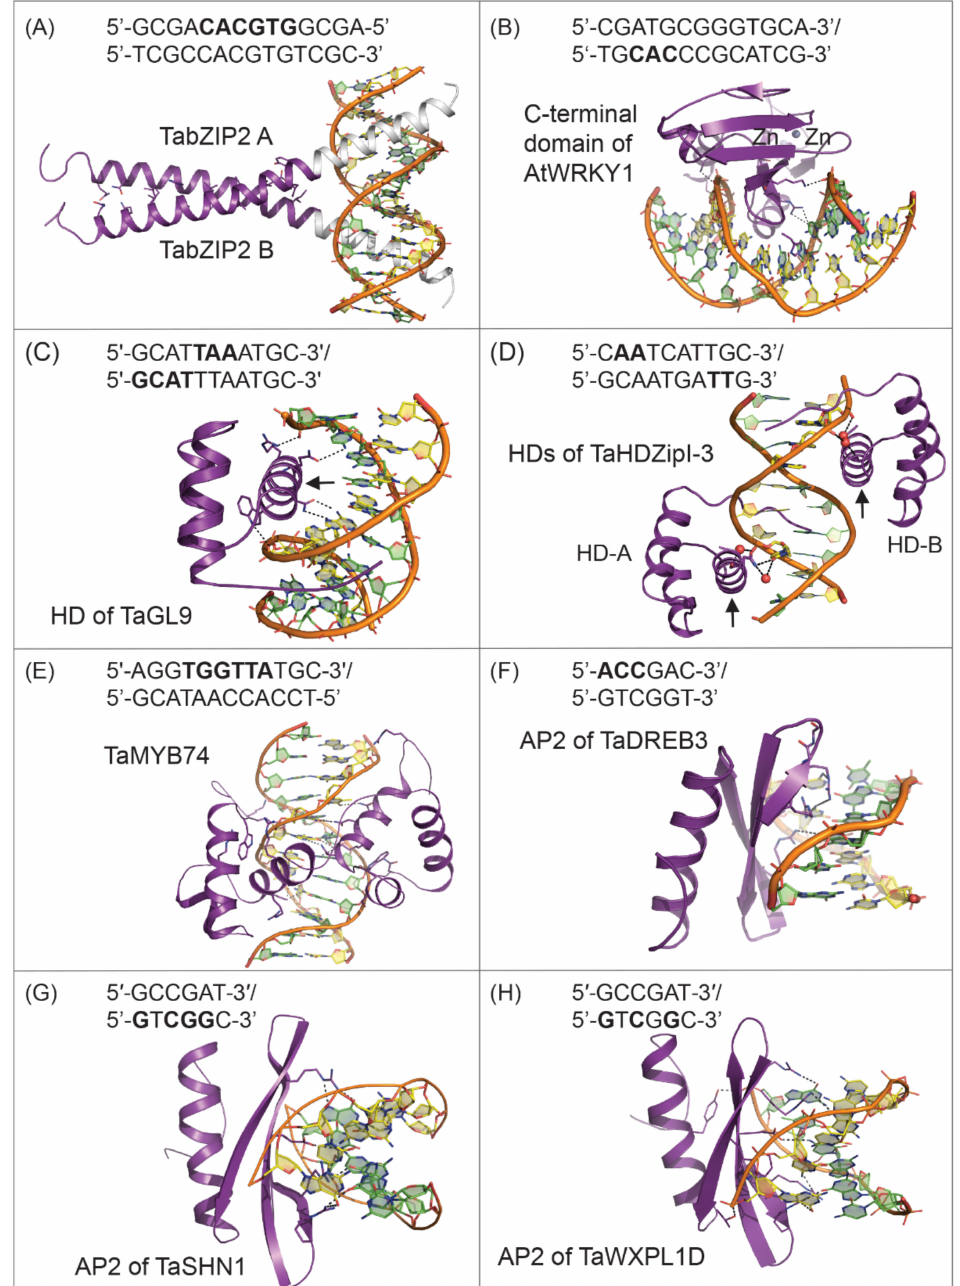
Figure 4. Structural characteristics of selected classes of wheat ( Triticum aestivum L.) and Arabidopsis thaliana (L. Heynh) TFs involved in drought and other abiotic stresses. Coding and complementary DNA strands are shown in cpk yellow and cpk green sticks, respectively. Residues that interact with DNA are shown in cpk purple sticks and separations are illustrated in black dashed lines. DNA nucleotides ( cis -elements) recognized by TFs are in bold. ( A ) bZIP: Molecular model of the wheat TabZIP2 homodimer (chains A and B) with the 5 (cid:48) -GGCCCACGTGGCCC-3 (cid:48) ABRE cis -element. The transcription factor consists of basic (light grey) and leucine zipper (purple) regions (modi- fied from [85]). ( B ) WRKY: Crystal structure of the C-terminal AtWRKY1 domain (PDB accession 1ODH) (traced in purple) illustrating antiparallel β -sheet contacting the 5 (cid:48) -CGATGCGGGTGCA- 3 (cid:48) /5-TGCACCCGCATCG-3 (cid:48) ) DNA fragment. Two zinc ions are shown in blue. Selected residues contacting DNA are shown at separations of ≤ 3.5 Å. ( C ) HD-Zip: Molecular model of the home- odomain (HD) of TaGL9 (purple) in complex with the 5 (cid:48)